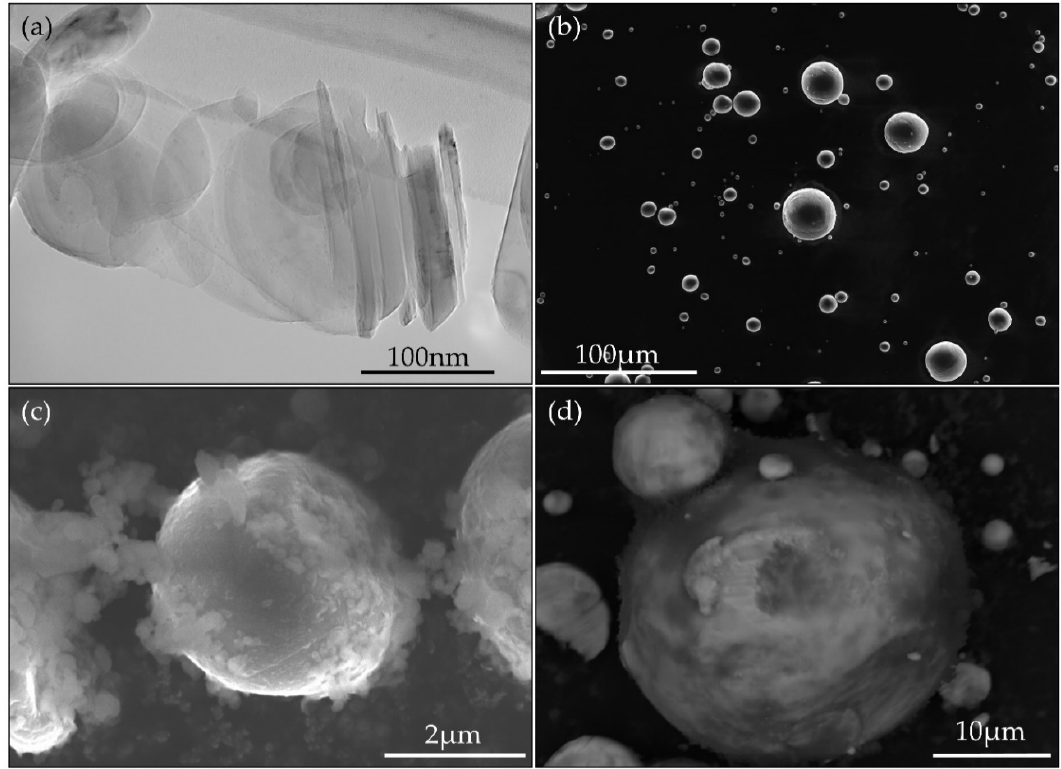
Figure 1. TEM and SEM images of powders before and after mixing: ( a ) TEM image of boron nitride powder as received; ( b ) SEM image of CP-Ti powder as received; ( c ) secondary electron SEM image of powders after mixing; ( d ) back-scatter electron image of powders after mixing.